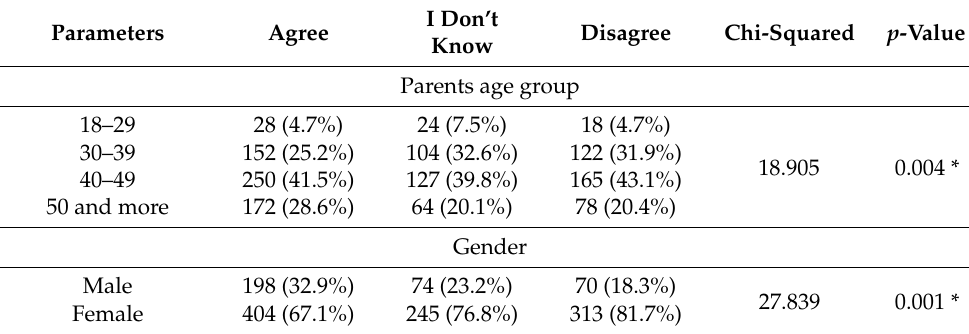
Table 2. Association of variables with the willingness of parents to give their children the vaccine (I intend to give my children who are 5–12 years old the COVID-19